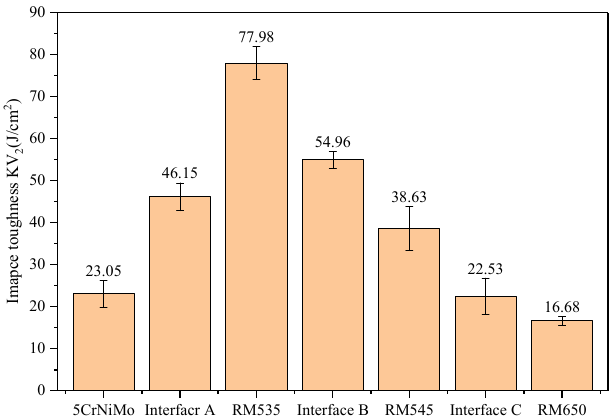
Figure 12. Impact toughness of gradient interfaces and deposition layers.